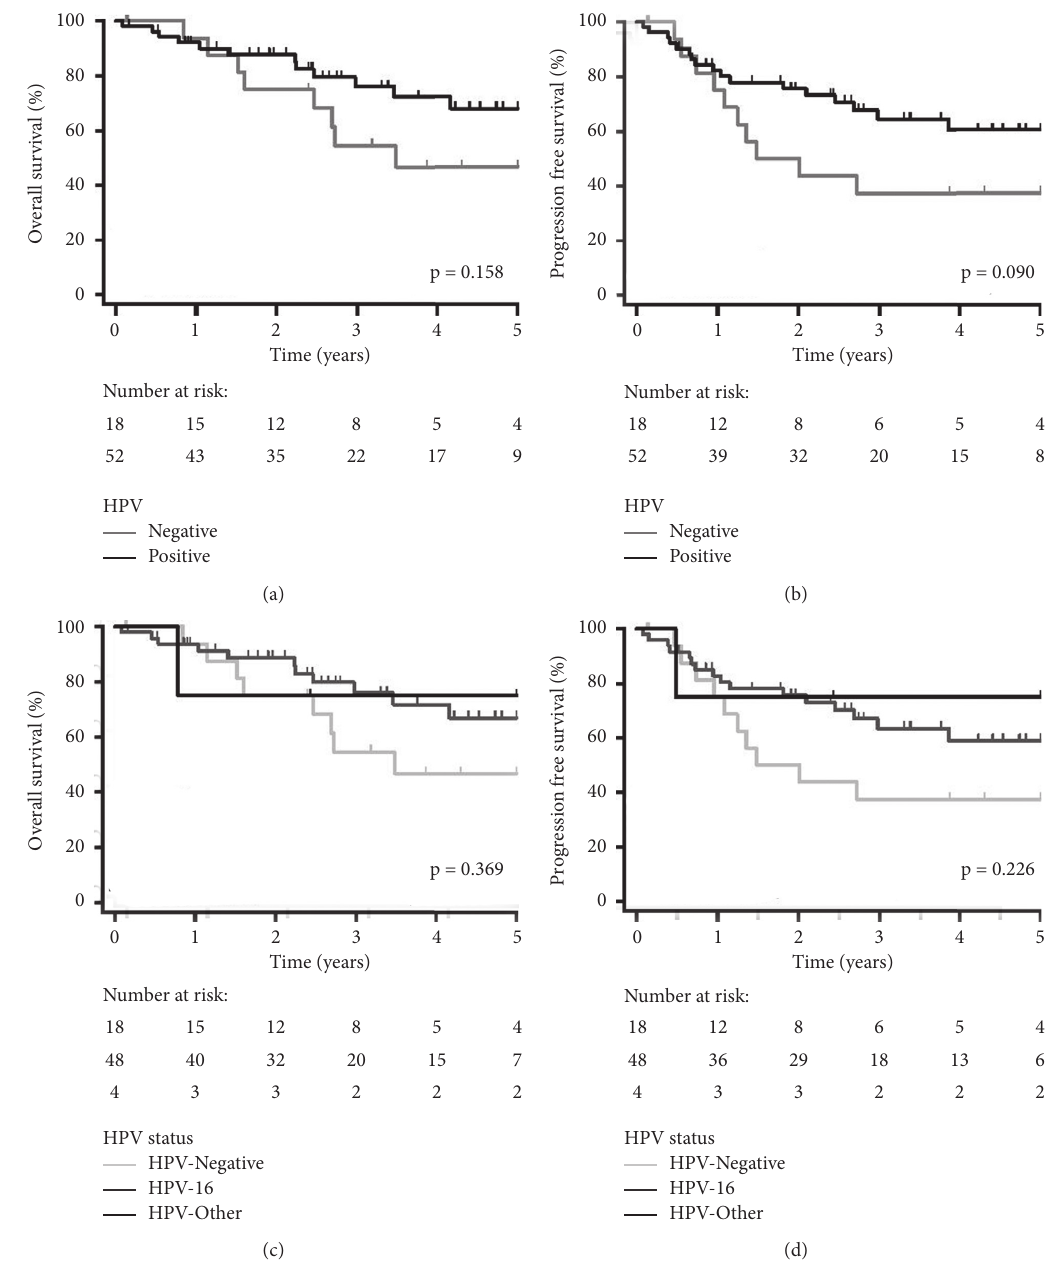
Figure 4: Kaplan–Meier plots stratified by HPV status (positive vs. negative) for (a) overall survival and (b) progression-free survival and stratified by HPV status (HPV-16 vs. HPV-other vs. HPV-negative) for (c) overall survival and (d) progression-free survival for patients with oropharyngeal cancer ( n �